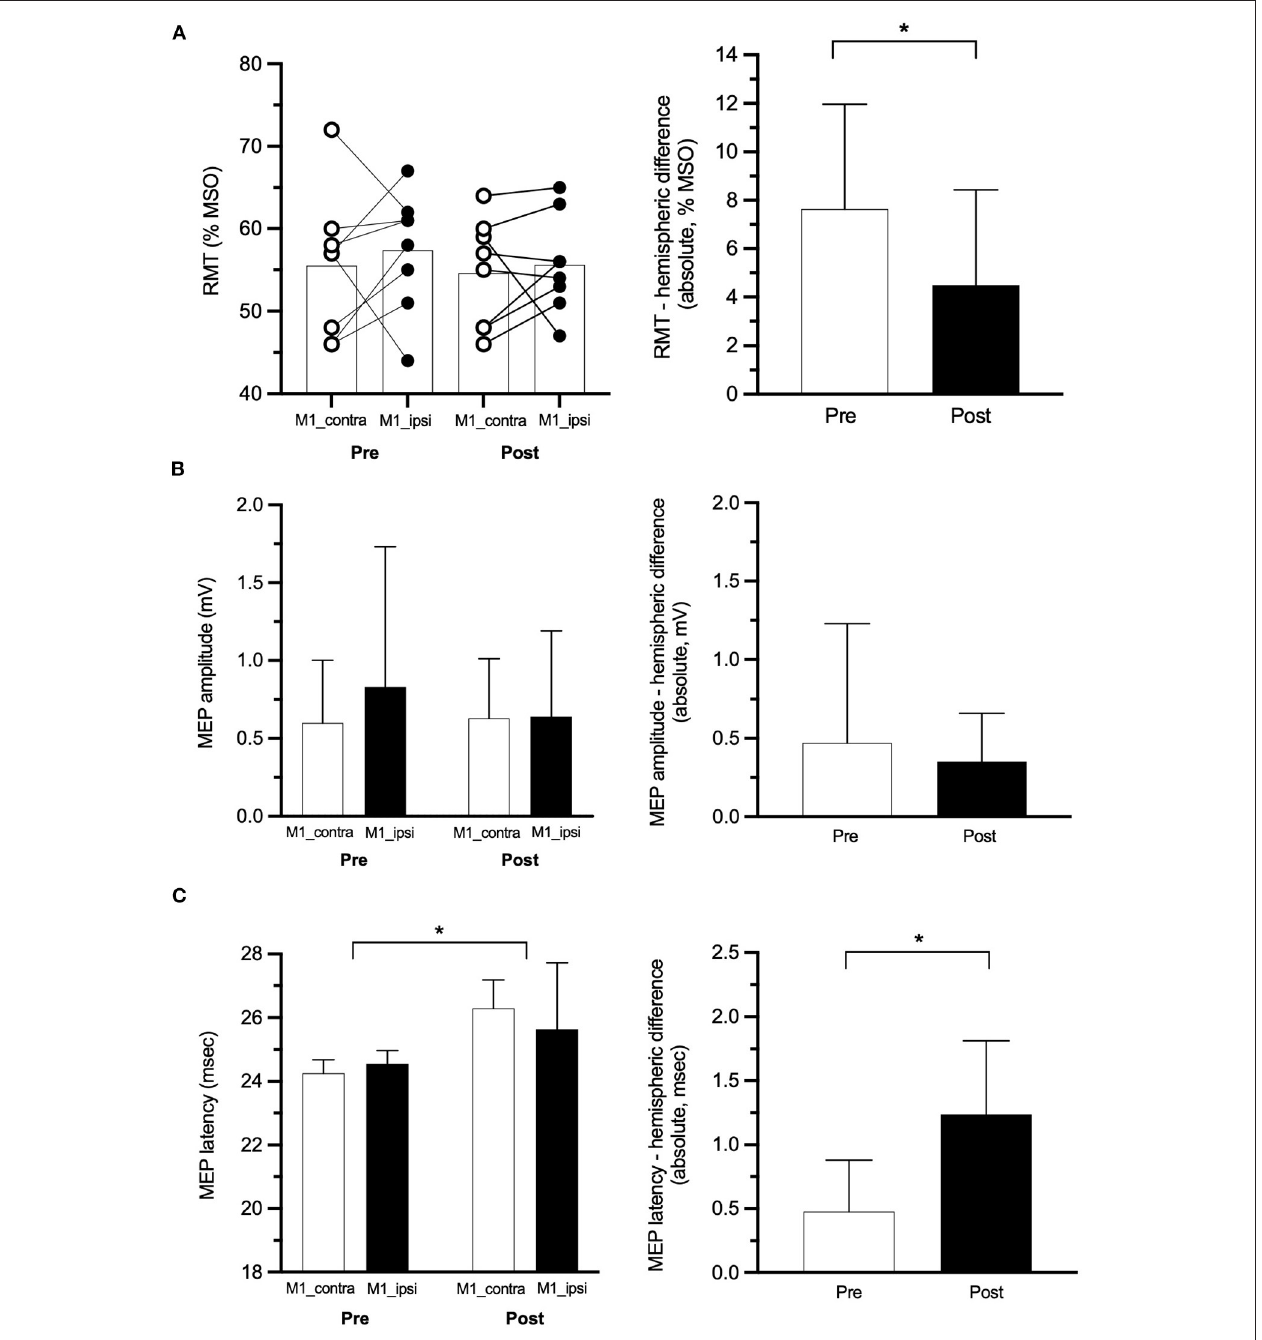
FIGURE 2 | Single-pulse transcranial magnetic stimulation (TMS) outcomes. (A) Left panel: individual values of RMT at pre- and post-rPMS with superimposed group means (histograms) for M1 contralateral to the complex regional pain syndrome (CRPS) side (M1_contra: white circles) and M1 ipsilateral (M1_ipsi: black circles), right panel: the absolute difference of RMT between M1_contra and M1_ipsi at pre- and post-rPMS (empty and filled histograms, respectively). Amplitude (B) and latency (C) of motor-evoked potentials (MEP) at pre- and post-rPMS for M1_contra and M1_ipsi (white and black histograms, respectively) on the left panel and, on the right panel, their absolute between-M1 difference at pre- and post-rPMS (white and black histograms, respectively). RMT, resting motor threshold, MSO, maximal stimulator output. * p < 0.05 between pre- and post-rPMS. (M1_contra with 59% more SICI than M1_ipsi) was reversed as compared to pre-rPMS (M1_contra with 64.88% less SICI than